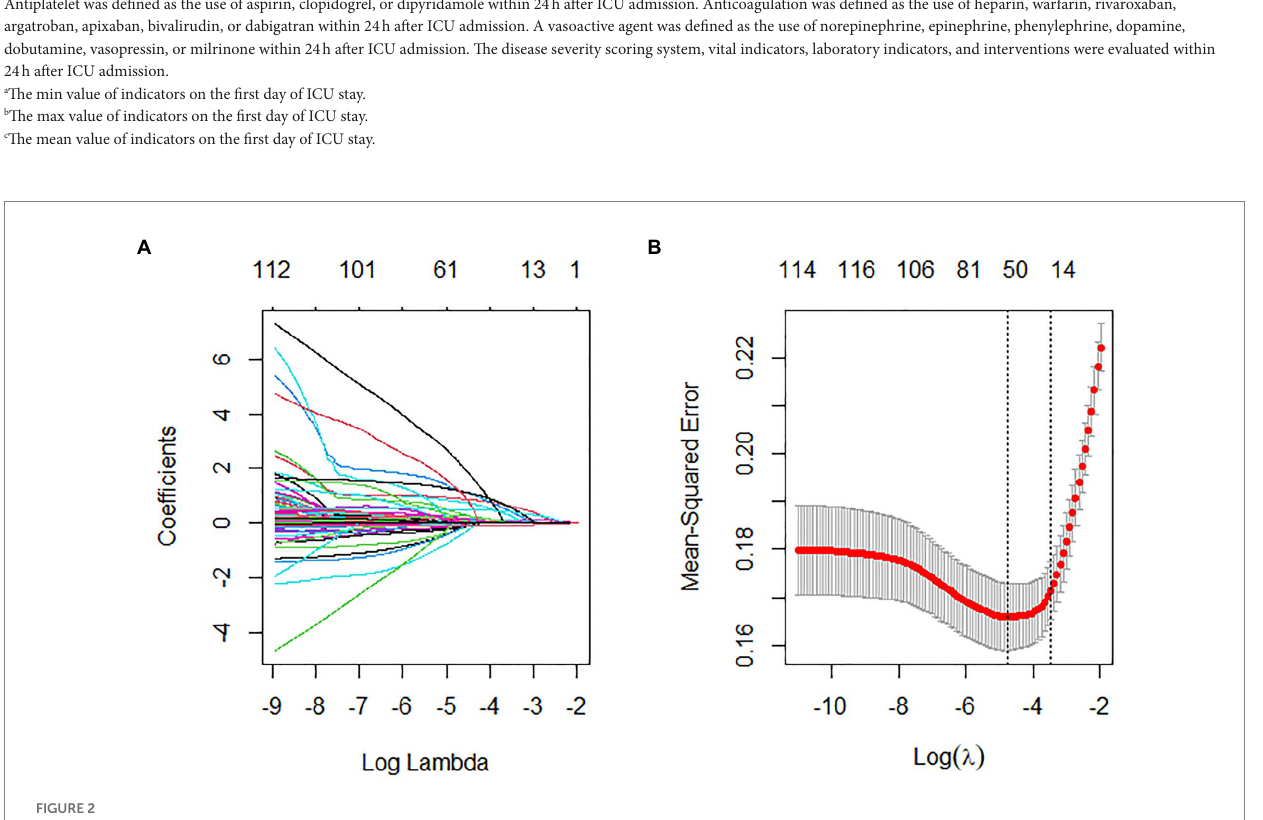
FIGURE 2 Selection of clinical features by least absolute shrinkage and selection operator (LASSO) regression and 10-fold cross-validation. (A) A visual plot of the relationship between coefficients for features and the lambda. The coefficient of each feature gradually tended to zero as the lambda value increased and (B) curve of 10-fold cross-validation in the LASSO regression. The dotted vertical line on the left reflects the number of features and optimal log (lambda) corresponding to the smallest mean squared error. With one standard error criterion of optimal log (lambda), the dotted vertical line on the right indicates that the model constructed with 13 variables was relatively accurate and simple ( λ = 0.03114428). λ ,